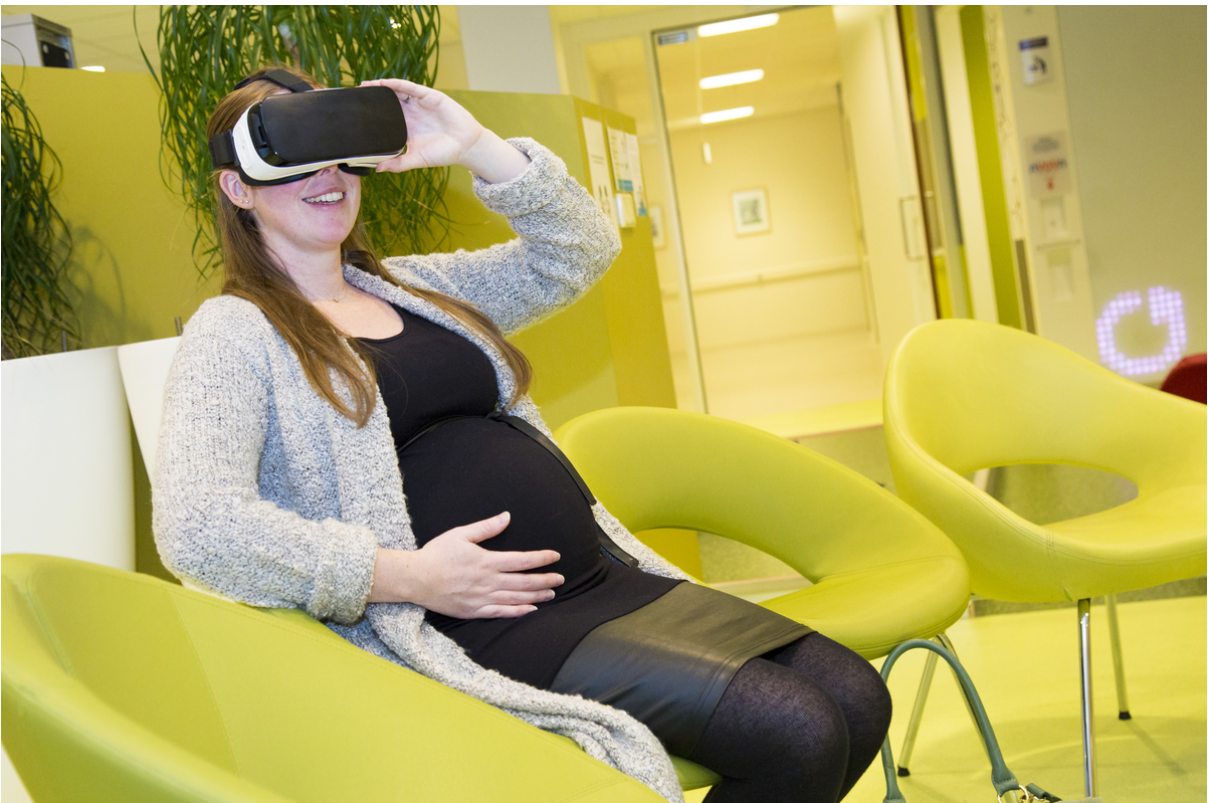
Figure 2. Illustration of the virtual reality glasses used.